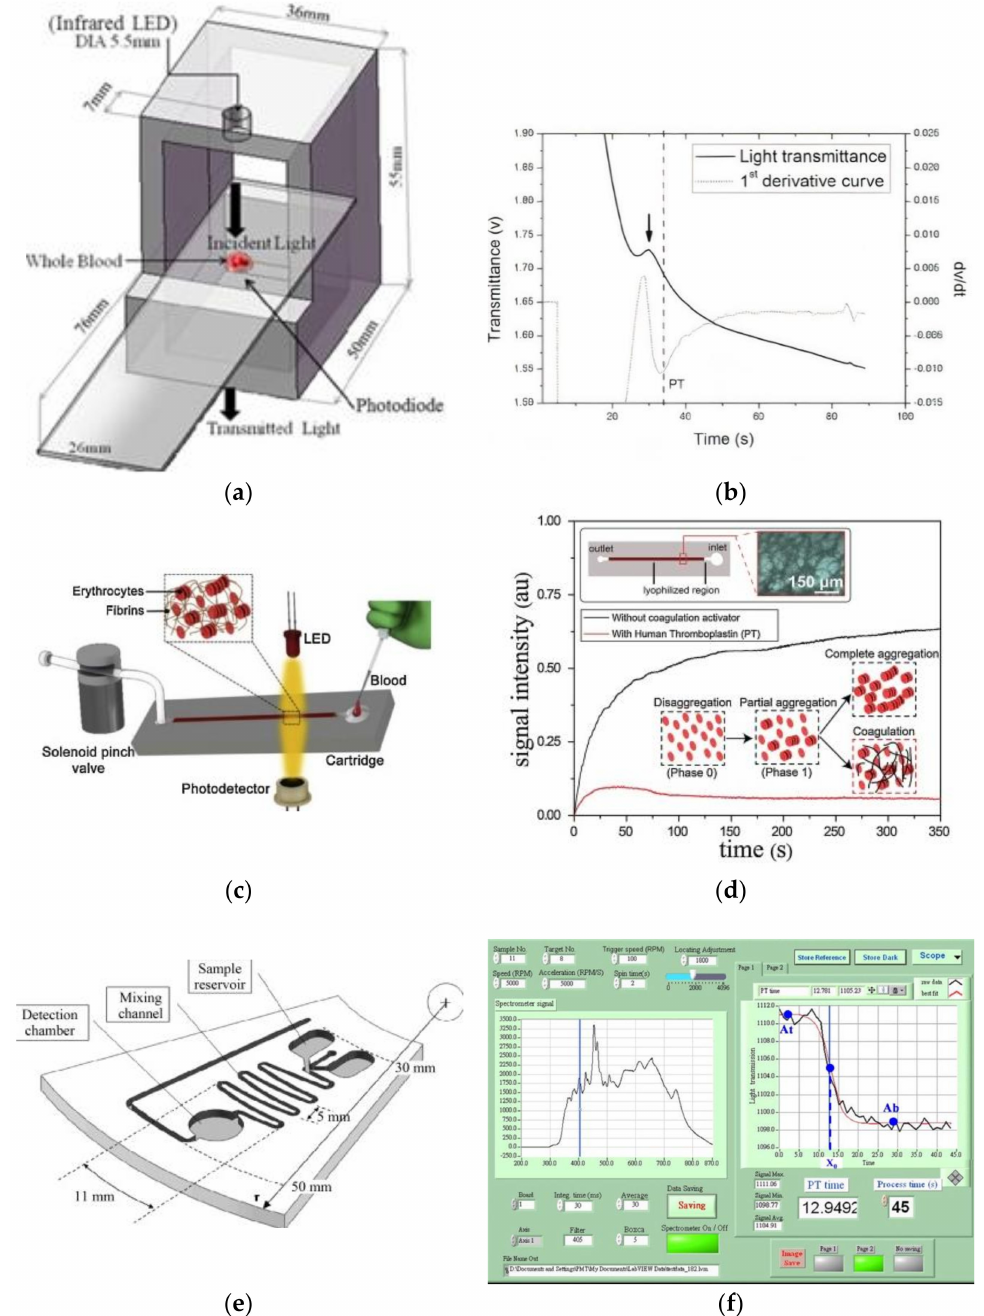
Figure 7. ( a ) Illustration of the transmission-based optical sensing module developed by Yang et al. ( b ) Plots for trans- mittance and its derivative for the whole blood during coagulation reaction. (Reprinted with permission from ref. [46]. Copyright 2013 Elsevier B.V.) ( c ) Schematic illustration of the coagulation time measuring platform developed by Isiksacan et al. in 2018. ( d ) Plots for the transmitted signal intensity of the whole blood w. r. t. time dispensed without any activator reagent and with PT reagent respectively. (Reprinted with permission from ref. [50]. Copyright 2018 Elsevier B.V.). ( e ) Illustration of the test cartridge of a microfluidic disc analyzer. ( f ) The graphical user interface for the PT test using a microfluidic disc analyzer (Reprinted with permission from ref. [31]. Copyright 2012 Elsevier